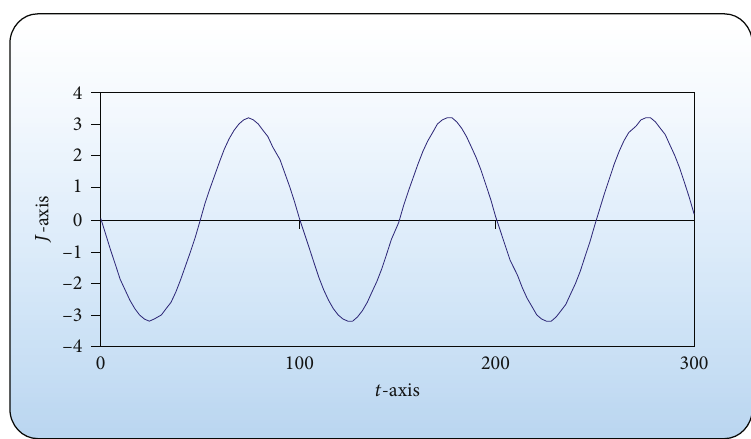
1 against the time t .